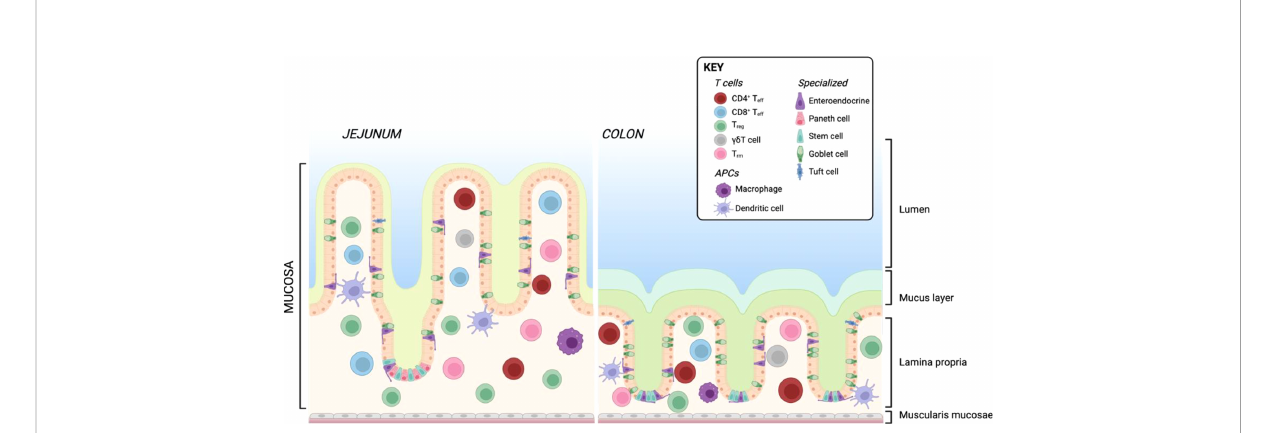
FIGURE 4 Resident T cells and APCs in the human small and large intestine. Created with